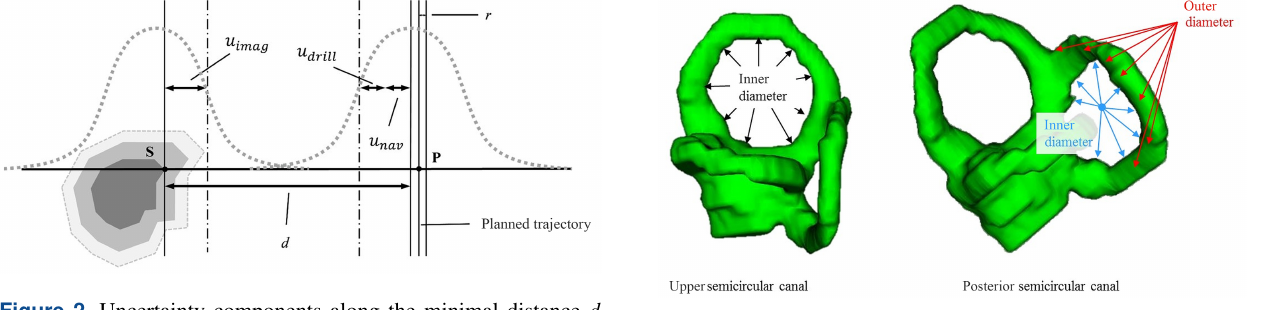
Figure 4. Explanation of the “inner/outer” diameter for the upper and the posterior semicircular